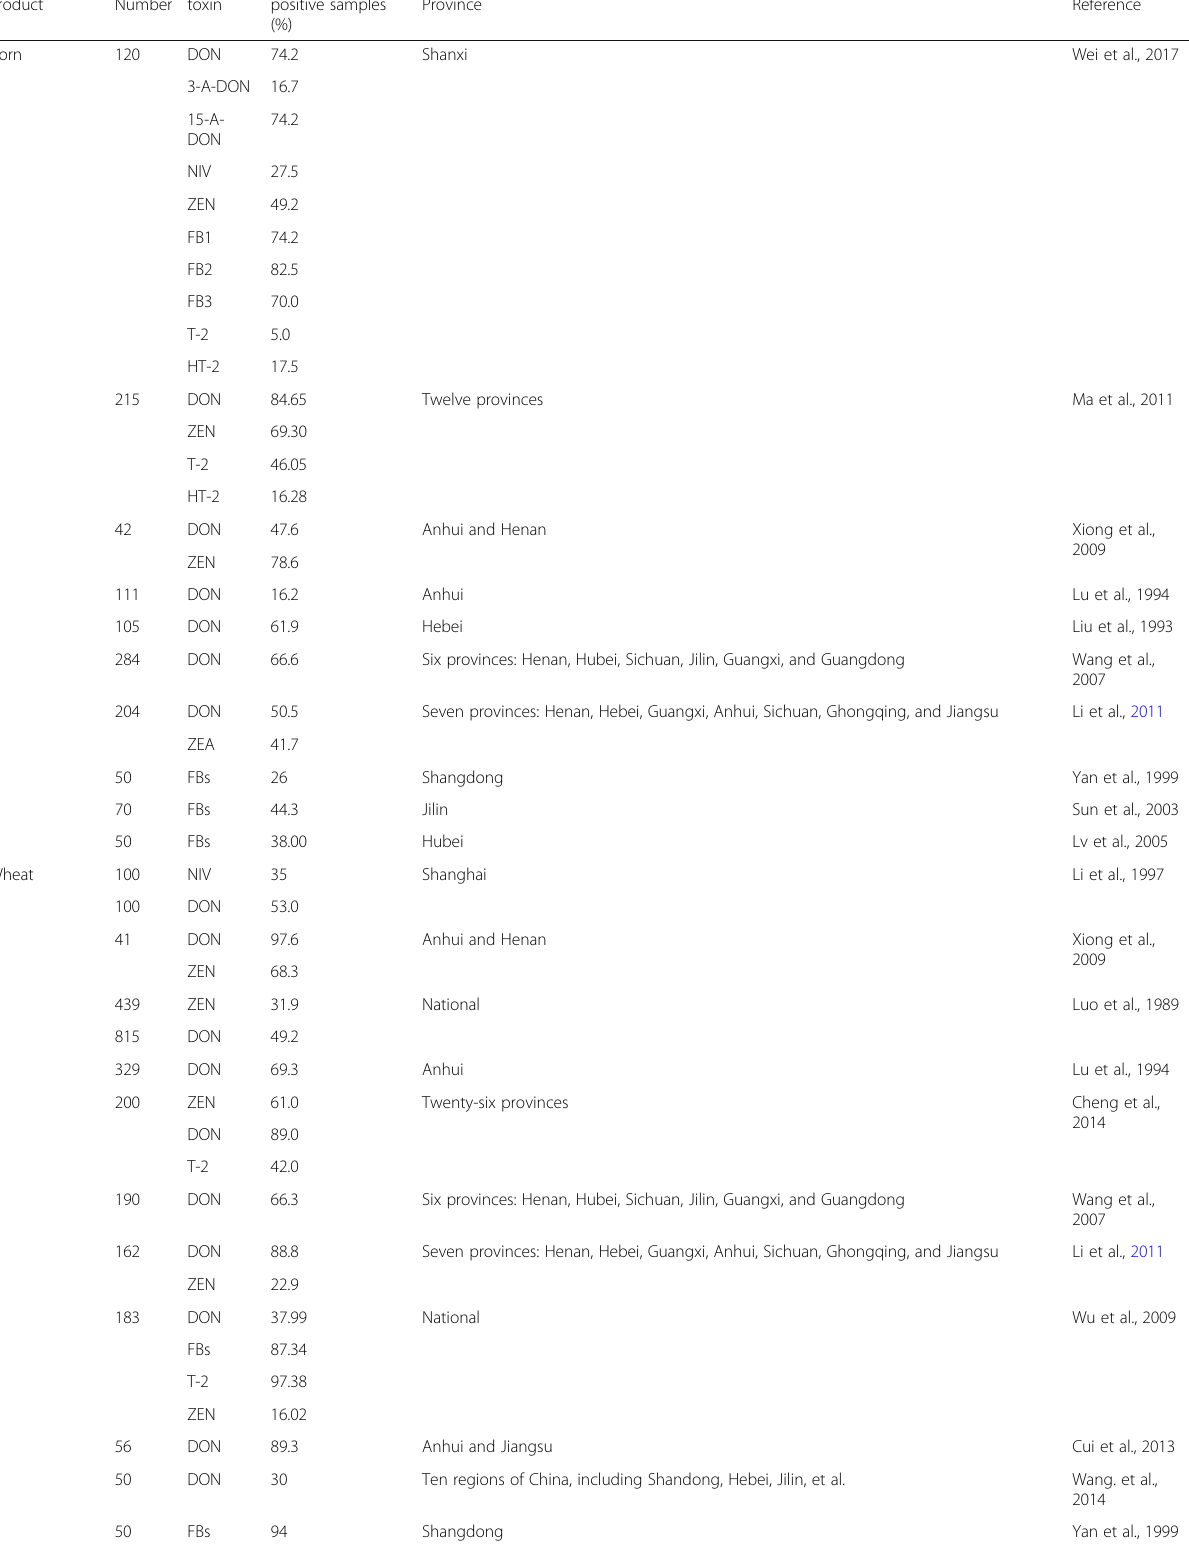
Table 4 Contamination of Fusarium mycotoxins in foods and feeds in China